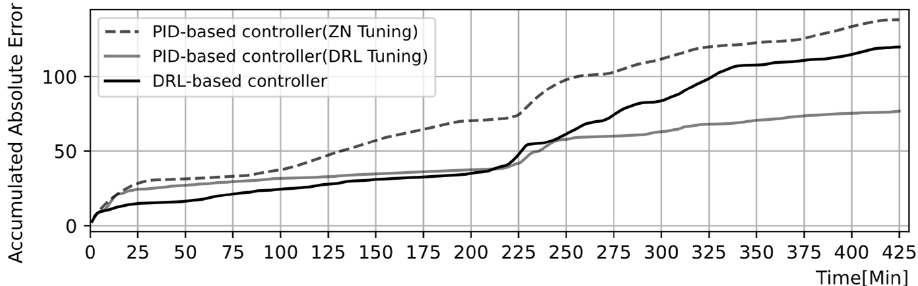
Figure 20. Comparisons of controllers for the pressurizer pressure.